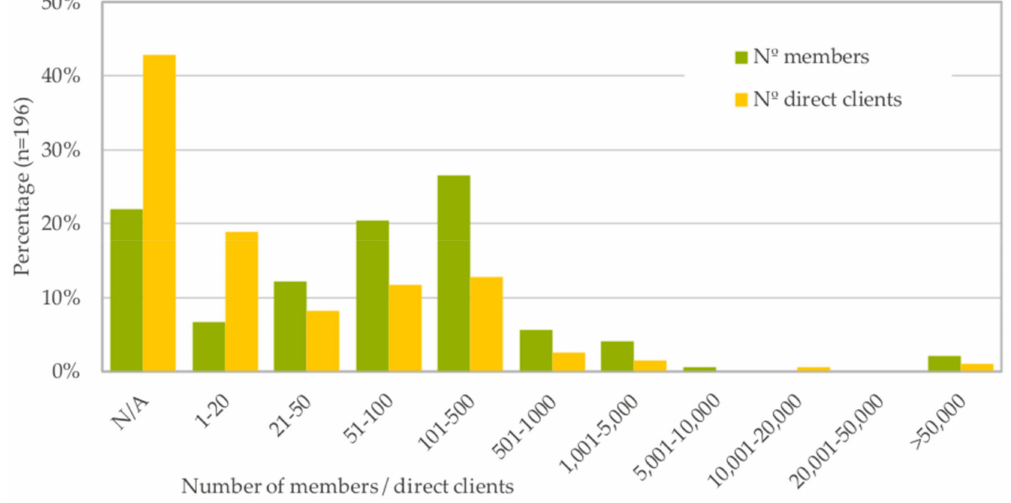
Figure 5. Number of members and / or direct clients of initiatives.